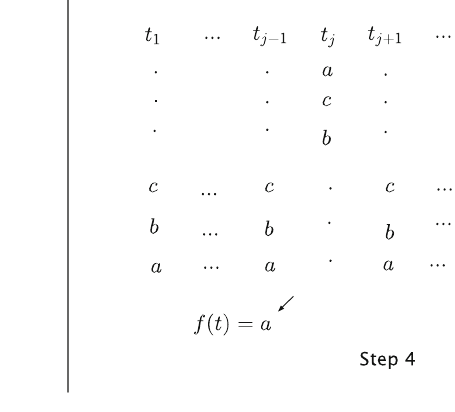
Fig. 3 Profiles w and